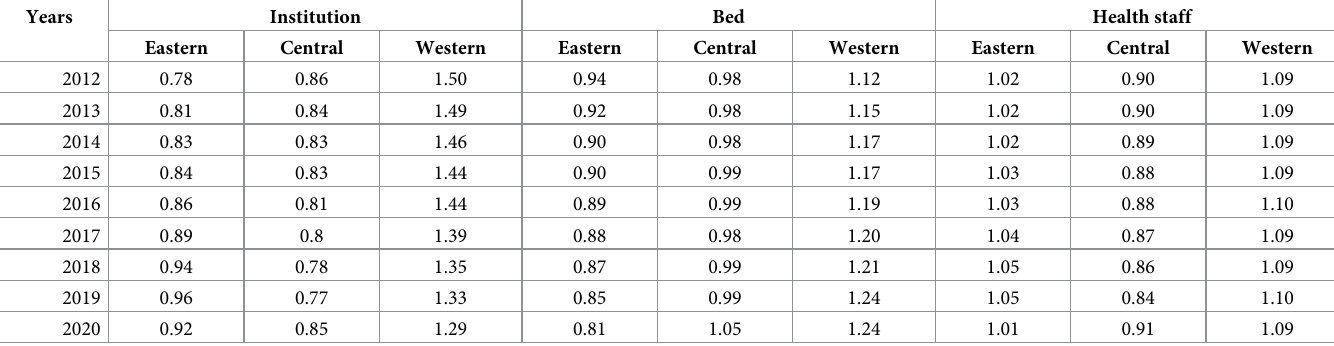
Table 4. The population-based agglomeration degree of TCM health resource from 2012–2020.